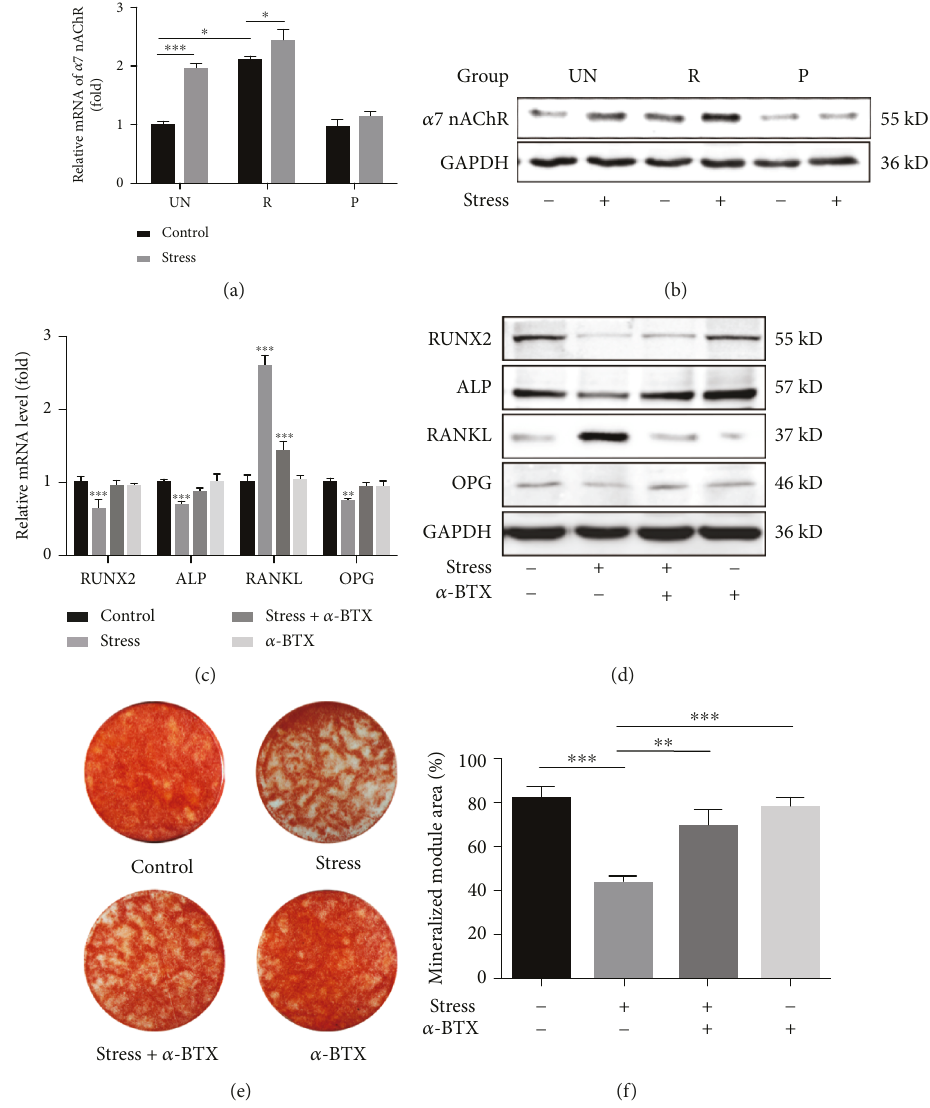
Figure 3: Mechanical pressure modulates the osteogenic and the osteoclastic di ff erentiation through α 7 nAChR in PDLSCs. (a) Relative mRNA expression of α 7 nAChR in PDLSCs from di ff erent groups. (b) Western blot assays demonstrated the expression levels of α 7 nAChR in PDLSCs from each group. (c) Relative mRNA expressions of RUNX2 , ALP , RANKL , and OPG from UN group PDLSCs. (d) Western blot assay results showed the expression levels of RUNX2, ALP, RANKL, and OPG in PDLSCs from UN group PDLSCs. (e) Alizarin red staining of PDLSCs from each group after culture in osteogenic medium for 21 days under stereomicroscope. (f) Quantitative analysis for the mineralized nodule of (e). The cyclic hydraulic pressure was performed with a fi xed frequency of 0.1Hz at di ff erent ranges for 2 hours/day for three consecutive days (a – d) and 21 consecutive days while performing the osteogenic di ff erentiation assays (e, f). Values have been expressed as mean ± SD . ( ∗ P ≤ 0 05 , ∗∗ P ≤ 0 01 , and ∗∗∗ P ≤ 0 001 ; one-way